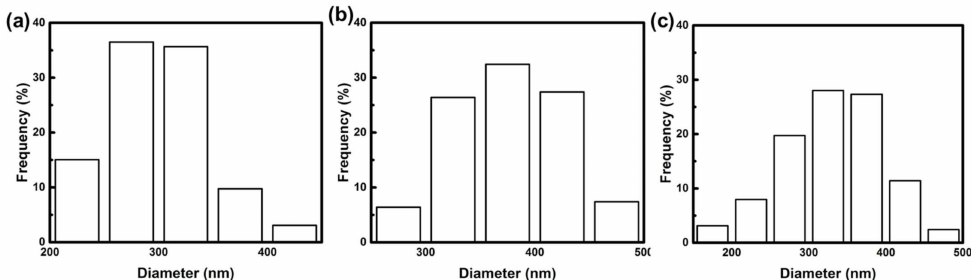
Figure 3. Diameter distribution of apertures in metallic nanomesh film samples with ( a ) polymer blend solution concentration of 4% and RIE time of 120 s, ( b ) polymer blend solution concentration of 5% and RIE time of 120 s and ( c ) polymer blend solution concentration of 5% and RIE time of 150